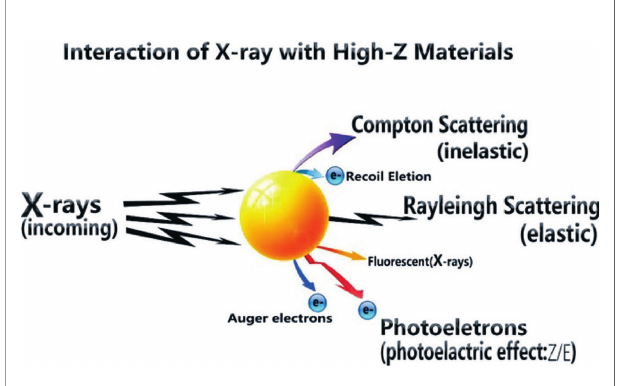
FIGURE 2 | Radiant energy deposition to arouse secondary electrons